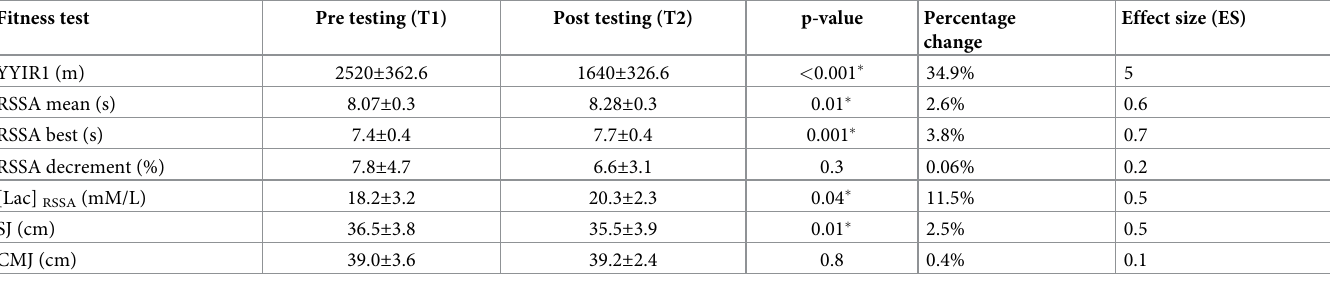
Table 3. Changes in performance in physical fitness tests after the period of match